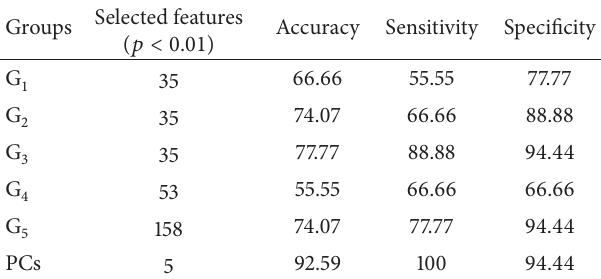
Table 4: Performance metrics (%) of ABC discrimination relied on texture feature